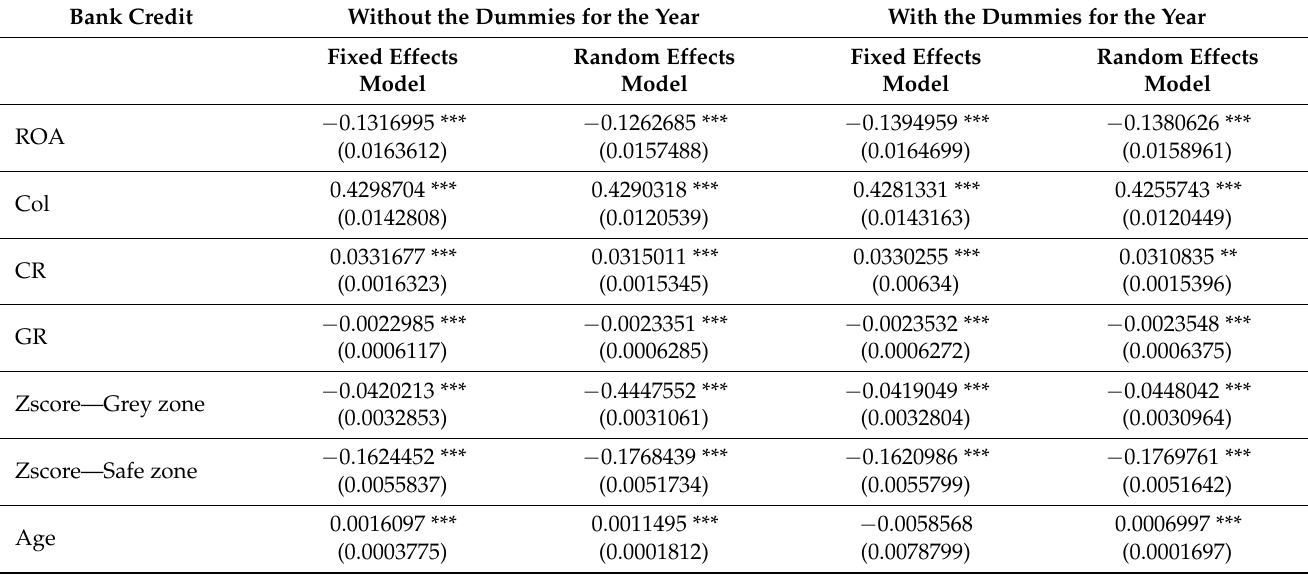
Table 3. Estimated models for bank